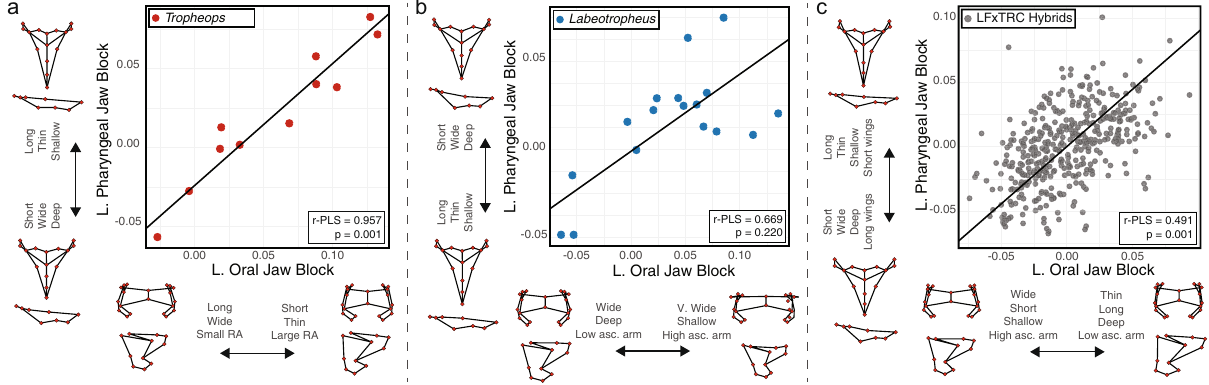
Fig. 3 Two-block partial least squares analysis to assess microevolutionary associations between lower oral and pharyngeal jaws. a Shape associations among Tropheops sp . “ red cheek ” (TRC) individuals ( n = 11). b Shape associations among Labeotropheus fuelleborni (LF) individuals ( n = 17). c Shape associations among members of a hybrid cross between TRC and LF ( n = 409). Oral and pharyngeal jaw wireframes denote morphologies at either end of the correlational axis. Source data are provided as a Source Data fi le.